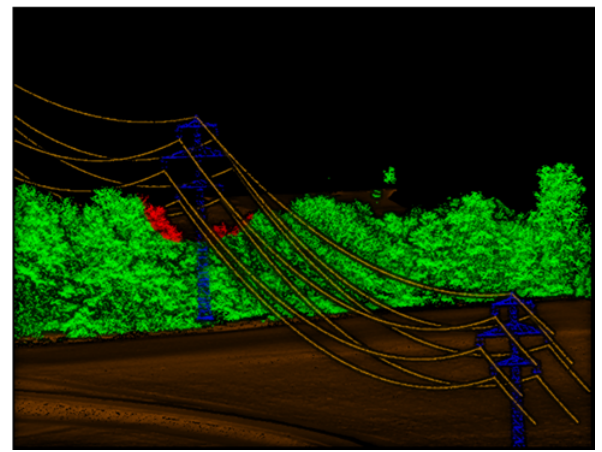
Figure 3. Detection of vegetation growing too close to a high- voltage